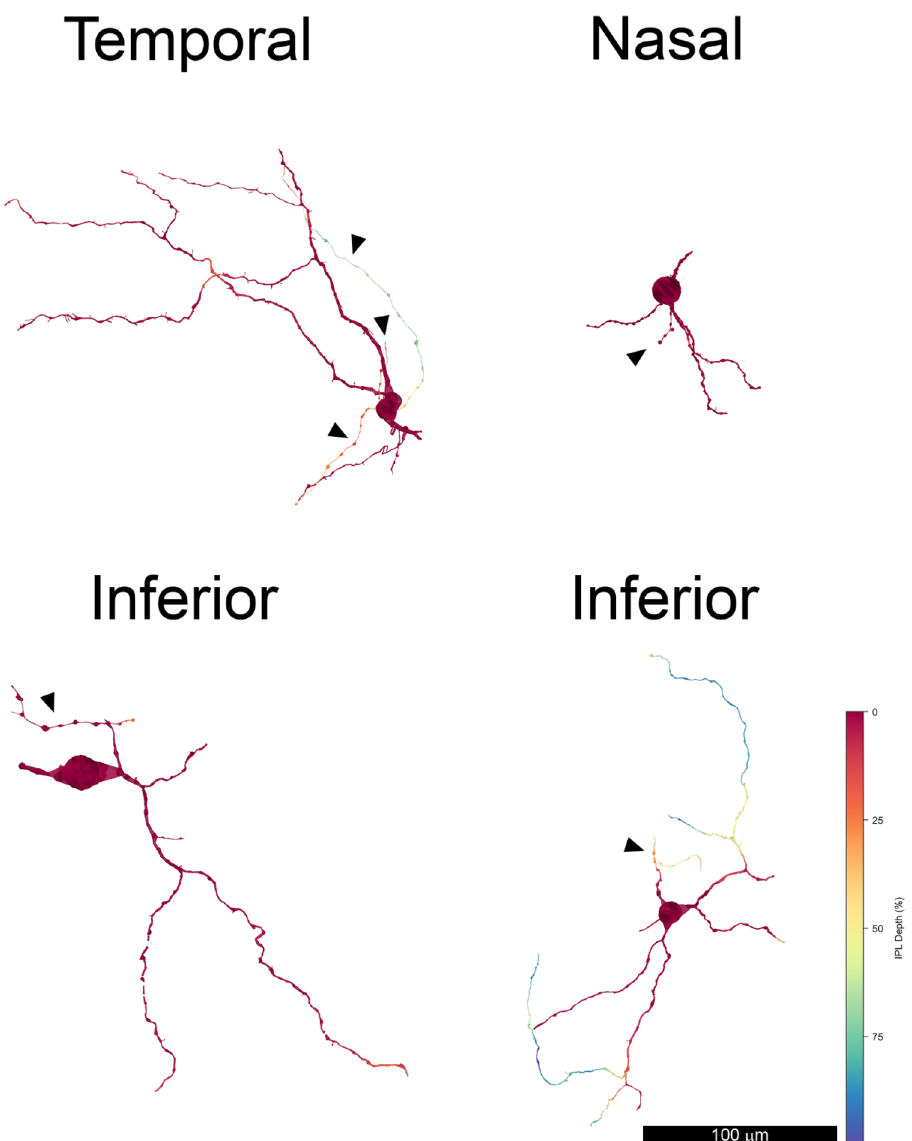
Figure 2. Displaced M1 ipRGCs were reconstructed in each volume: 6210 temporal, 11,345 nasal and 1178 inferior. A smaller displaced ipRGC, 21,551, was also reconstructed in the inferior volume (bottom right). Note that its distal dendrites descended into the inner half of the inner plexiform layer, as indicated by the green and blue pseudocolors. Some dendrites and the soma of cell 6210 from the temporal volume ran off the edges of the volumes, and the axons ( ▲ ) were